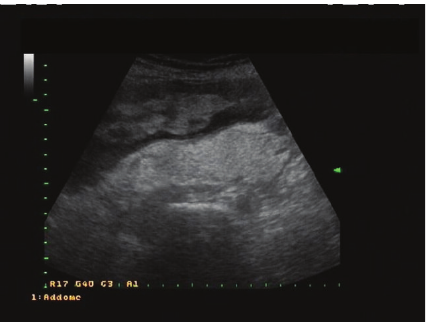
Figure 3: Macroscopic appearance of the mass which is well encap- sulated and multilobed. It has gelatinous and rubbery consistency.